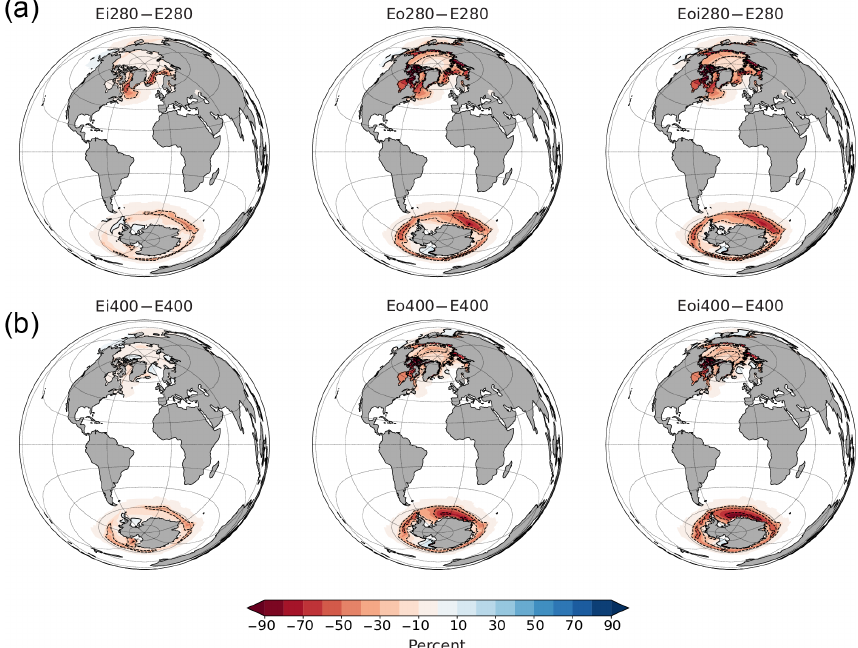
Figure 12. Climatological sea ice concentration anomalies of the five sensitivity experiments and the 400ppmv mid-Pliocene experiment with respect to controls. The control experiment is chosen such that the p CO 2 is identical between the experiment and the control. (a) The anomalies for 280ppmv p CO 2 experiments and (b) the anomalies for 400ppmv p CO 2 experiments. The climatology years are noted